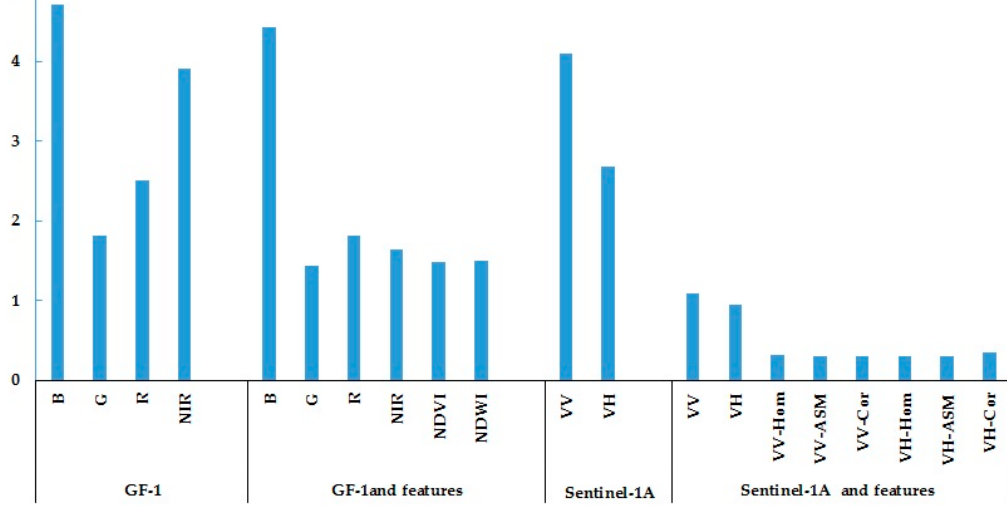
Figure 4. Feature importance.